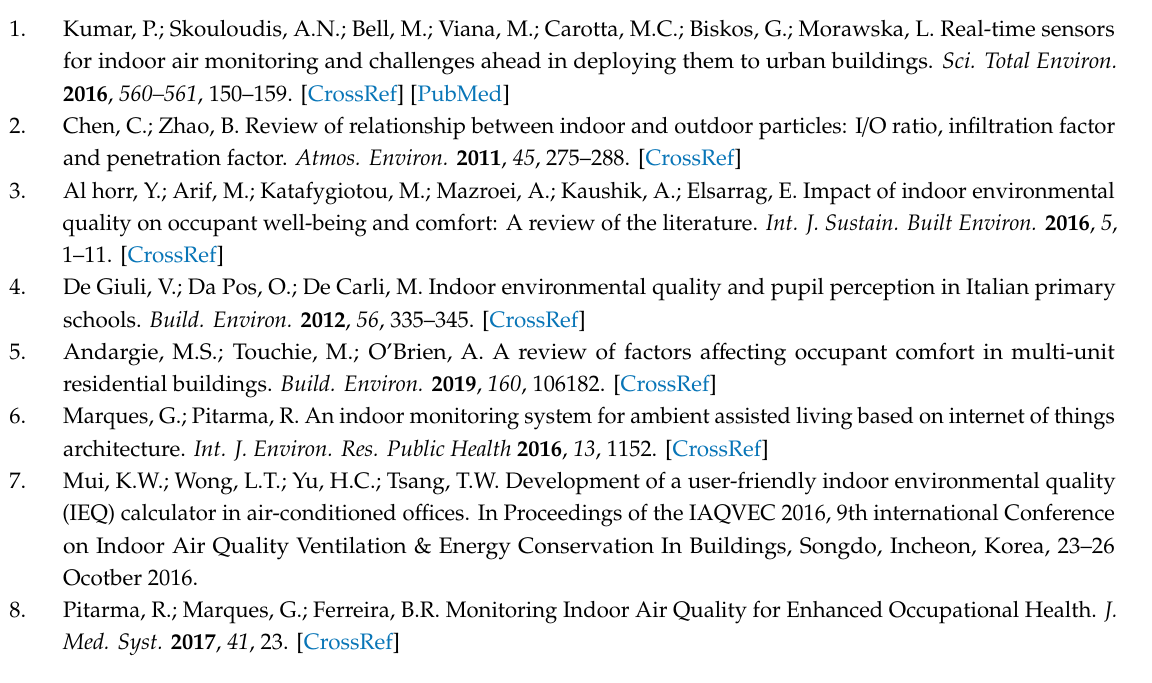
Table S1: Preferred Reporting Items for Systematic reviews and Meta-Analyses extension for Scoping Reviews (PRISMA-ScR)